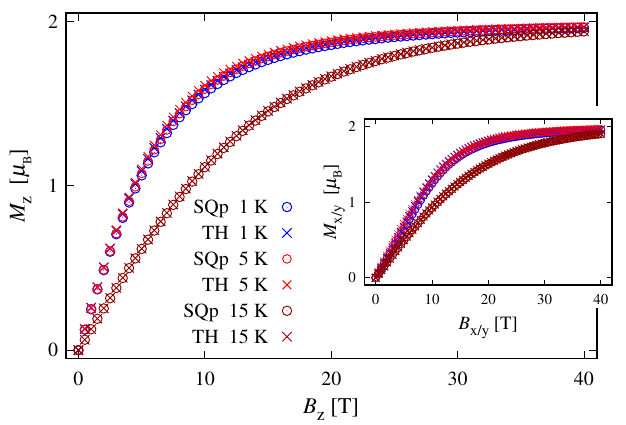
Figure 9. The magnetization of the square planar (SQp) and tetrahedral (TH) complexes for different temperatures. The values of all model parameters provided at the end of Section 2.1. The subscript x / y in the inset represents both x and y